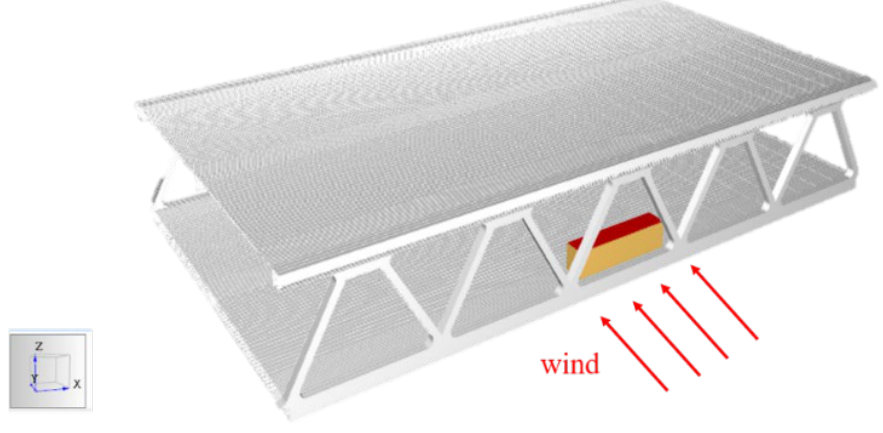
Figure 1. Three-dimensional (3D) view of the bridge.